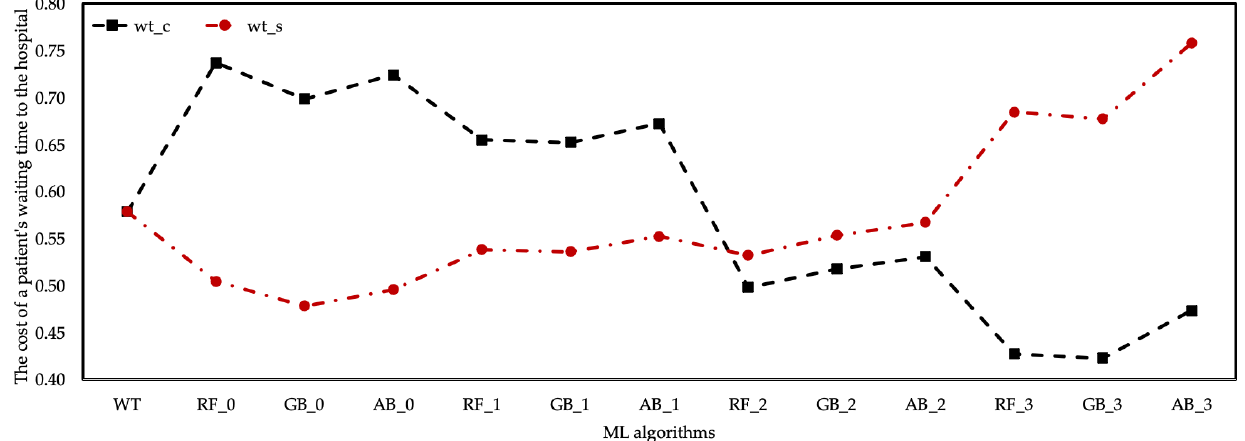
is based on the t is based on the δ i 𝑤𝑤 𝑛𝑛